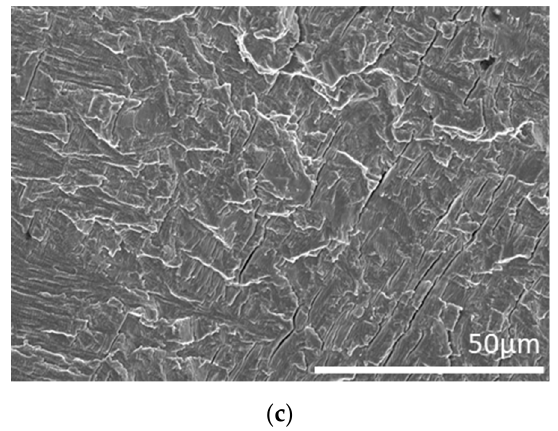
Figure 11. Fractography of ( a ) IFCG 500 °C ( b ) TMFCG IP 200–500 °C and ( c ) TMFCG OP 200–500 °C, all of which show transgranular/mixed-mode cracking.